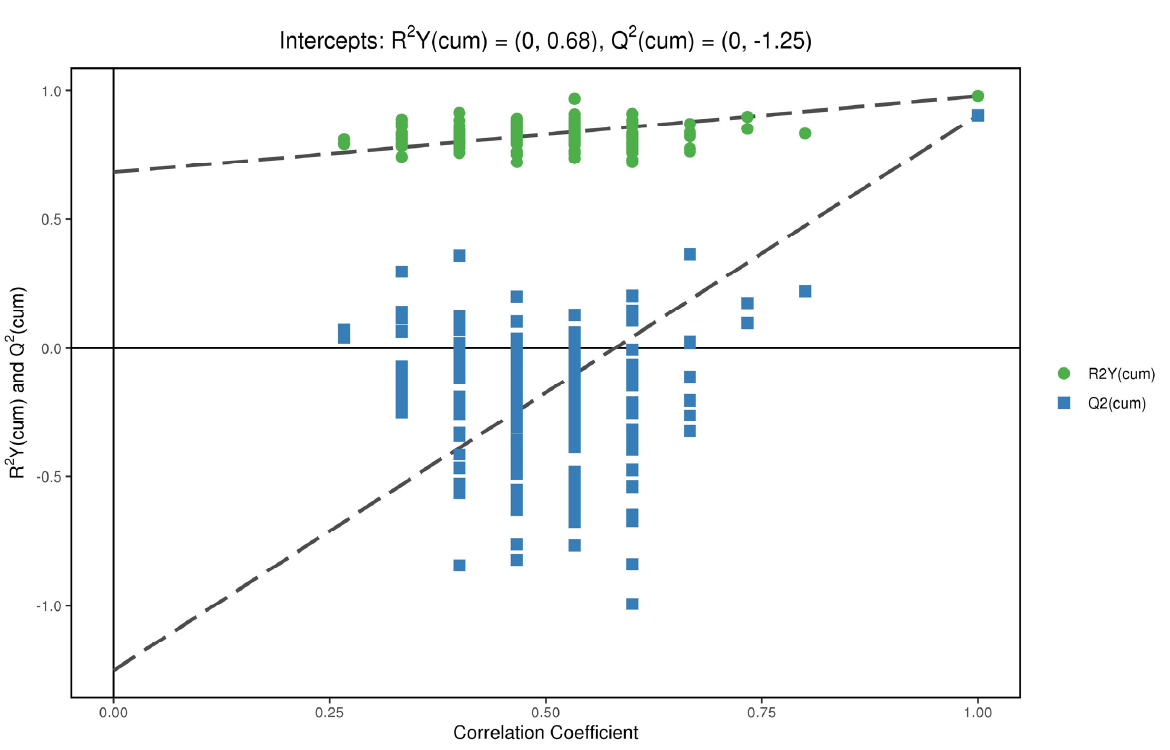
Figure 10. Replacement test of